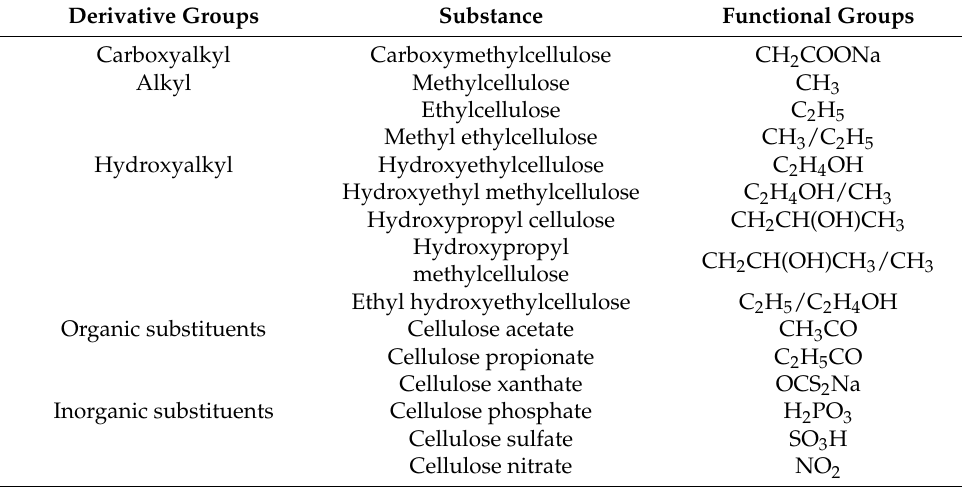
Table 1. Cellulose derivatives widely discussed in the literature *.